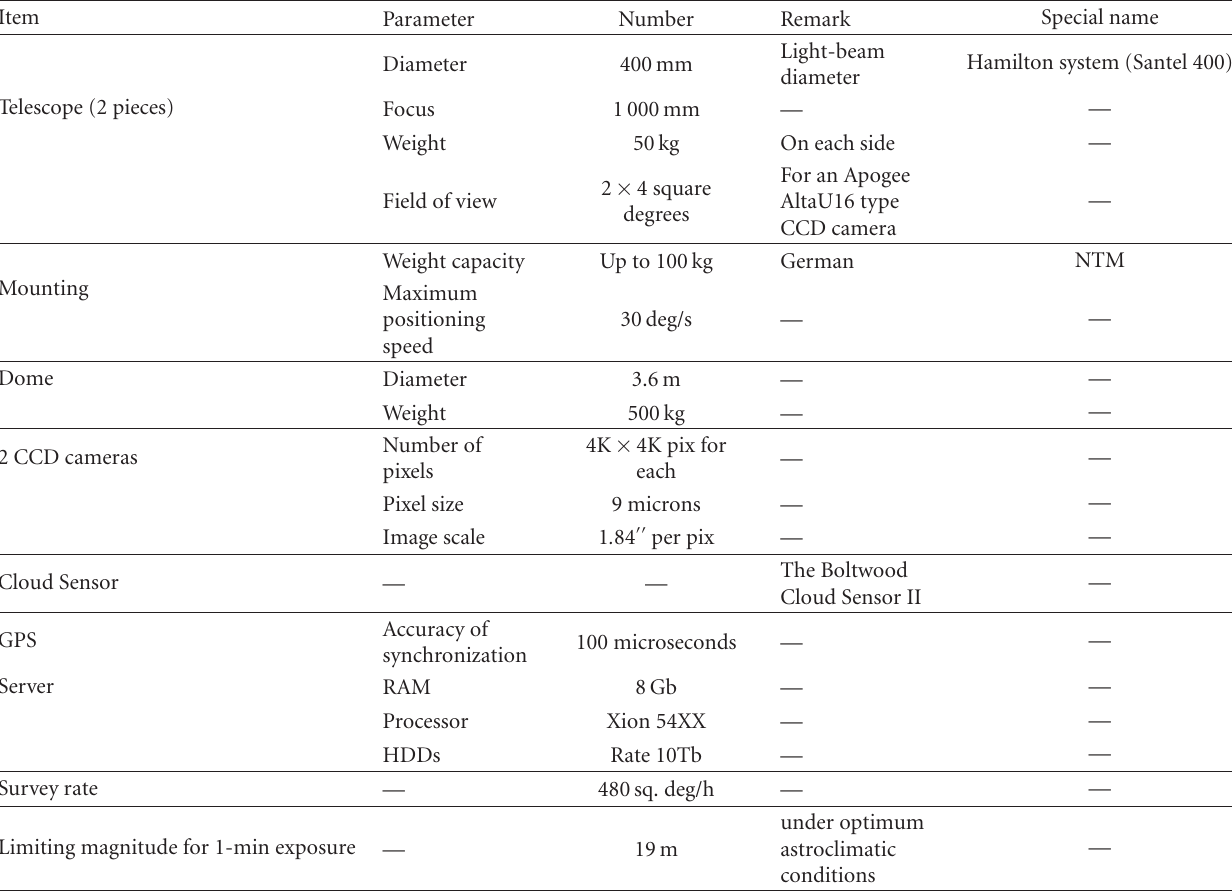
Table 1: Composition and specification of MASTER II telescope.